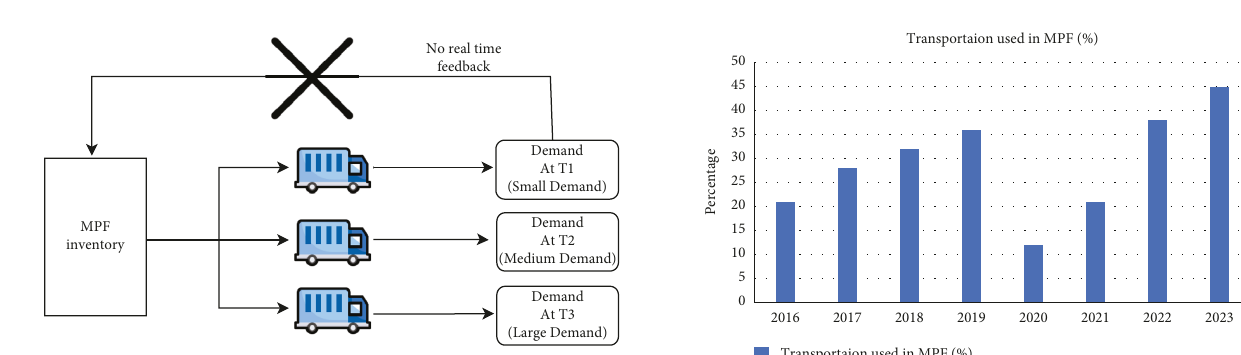
Figure 1: Traditional MPF inventory and supply